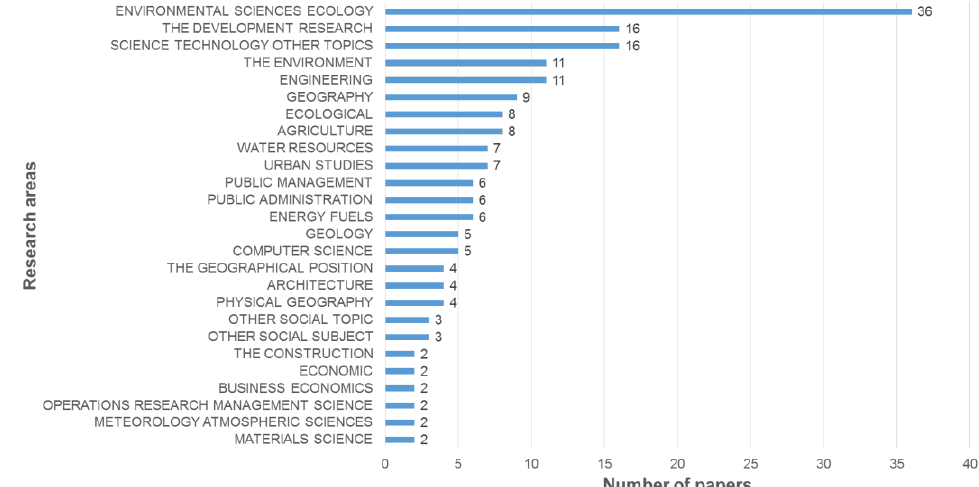
Figure 5. Distribution of publications based on research areas.